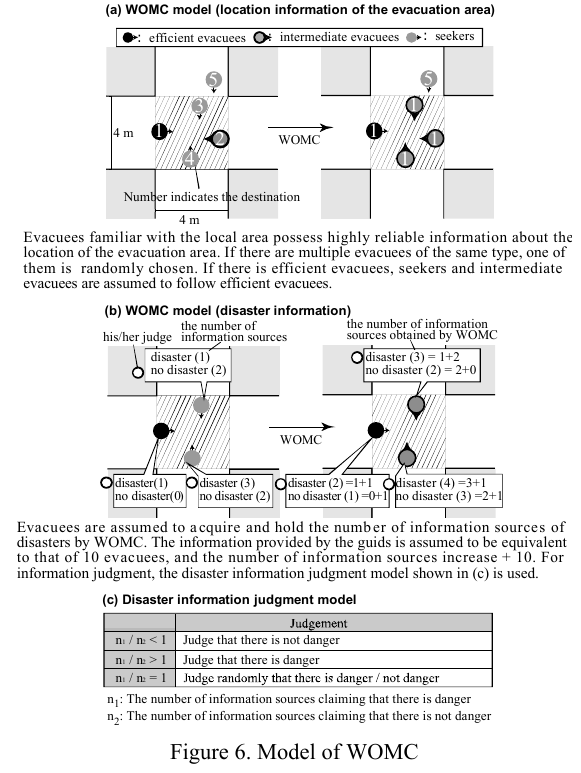
Figure 6. Model of WOMC